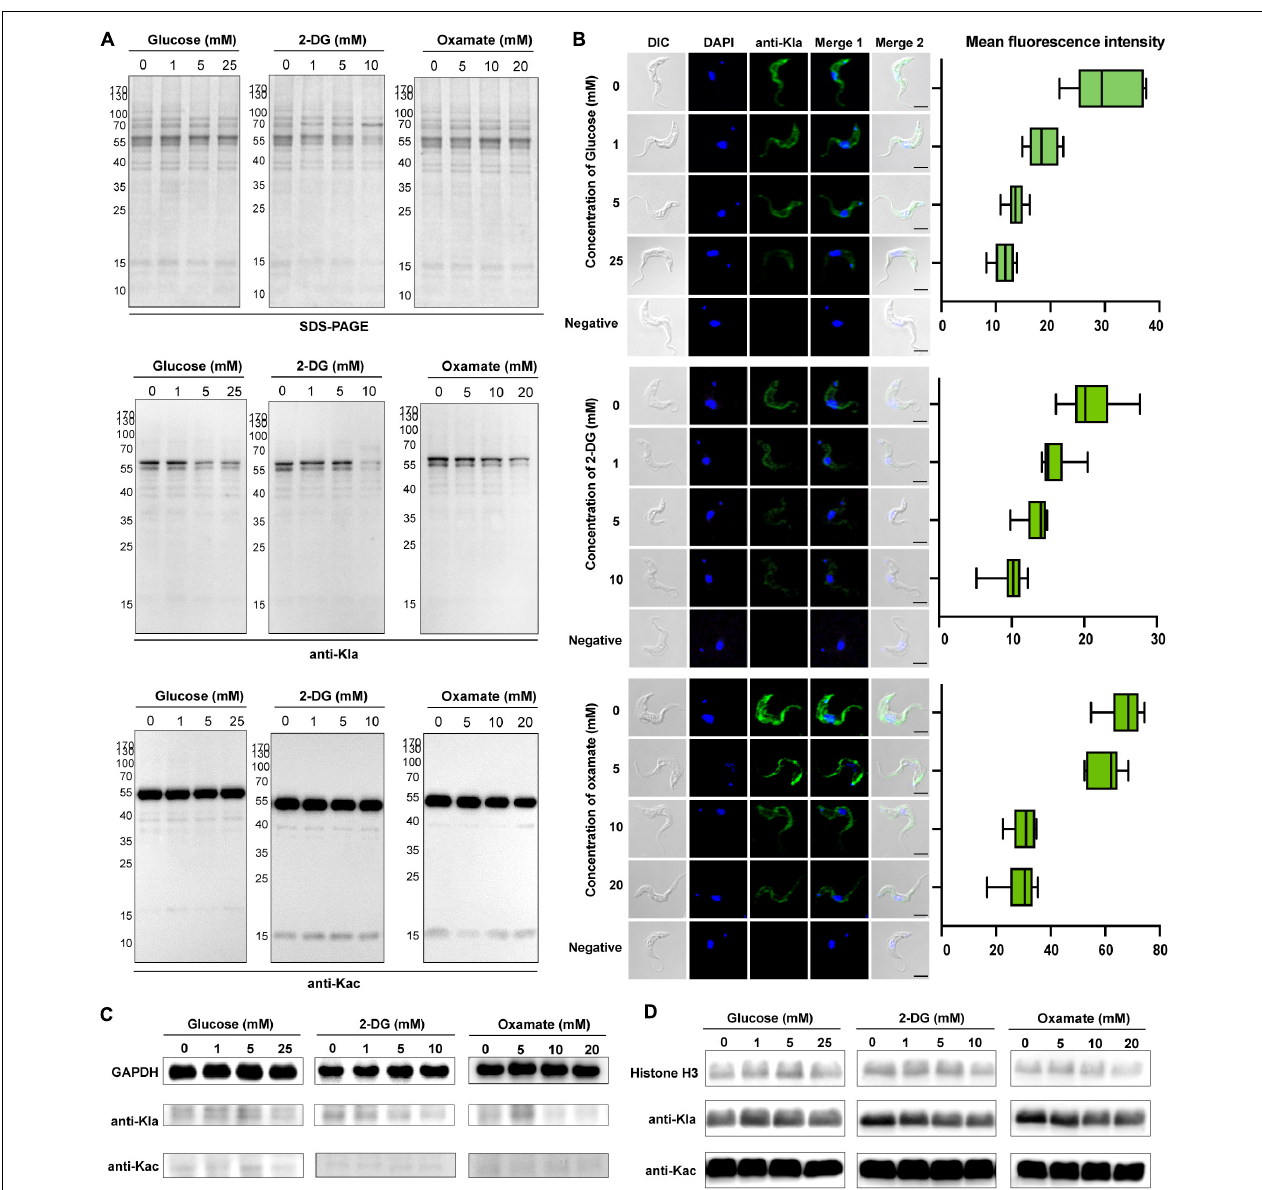
FIGURE 5 | Kla is stimulated by lactate and contributes to gene expression. (A) SDS-PAGE and immunoblots of total T. brucei lysates in response to various glycolysis modulators. The upper panel shows equal loading amounts by SDS-PAGE. The middle and the lower panels show Western blotting assay probed with a monoclonal anti-lactyllysine antibody and anti-acetyl lysine antibody, respectively. (B) Immunofluorescence of lactylated T. brucei proteins with an anti-Kla antibody under the same exposure times, parameters, and statistics of mean fluorescence intensity. The fluorescence intensity decreases with the increases in glucose, 2-DG, and oxamate concentrations. Scale bar, 10 µ m. (C,D) Immunoblots of GAPDH obtained by IP (C) and extracted histones (D) from T. brucei in response to various glycolysis modulators. The upper panel shows equal loading amounts with antibodies of target proteins. The middle and the lower panels show Western blotting assay probed with a monoclonal anti-lactyllysine antibody and anti-acetyl lysine antibody, respectively. The gray scale of the bands in the groups of 2-DG and oxamate incubated with the anti-KLa antibody decrease with the